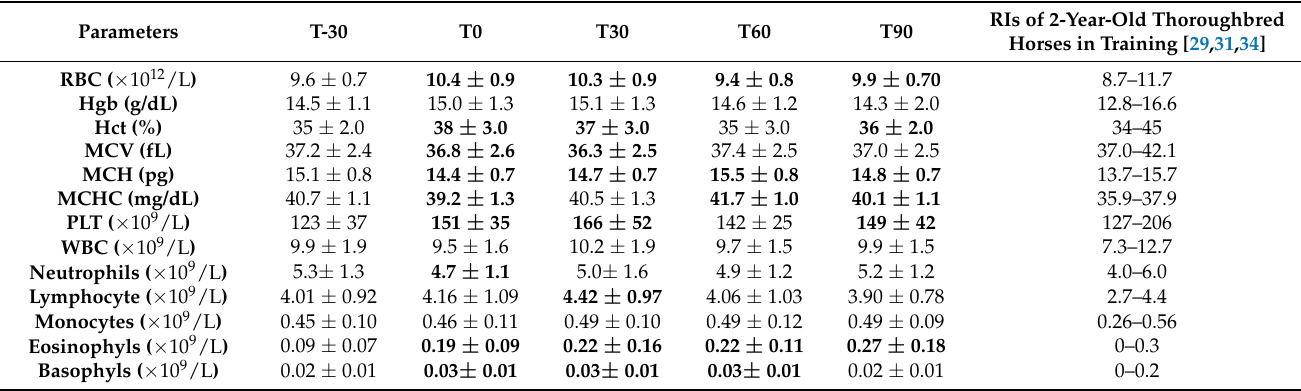
Table 2. Means ± SD of completed blood count (CBC) parameters. Parameters significantly modified compared with T-30 are indicated in bold.